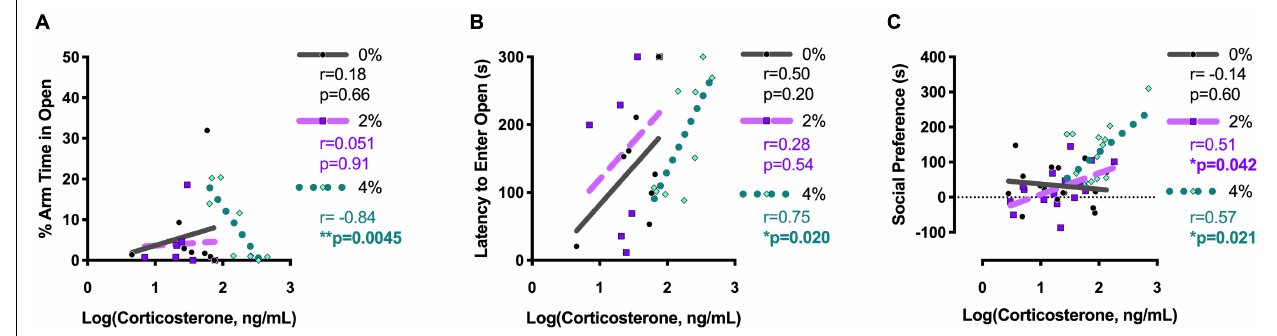
FIGURE 5 | Pearson correlations between log-transformed corticosterone levels and behavior in the elevated plus maze and social interaction test. Pearson correlations between individual log-transformed serum corticosterone levels and percent arm time spent in the open arms of the elevated plus maze (A) and latency to first open arm entry in the elevated plus maze (B) were determined for group housed mice in Experiment 2. Pearson correlations between individual log-transformed serum corticosterone levels and social preference in the social interaction test were determined after collapsing across housing conditions for mice in Experiments 1 and 3 (C) . Pearson r- values are reported on the right side of each corresponding graph, along with the associated p -value. Bolded and asterisked p -values indicate values < 0.05.